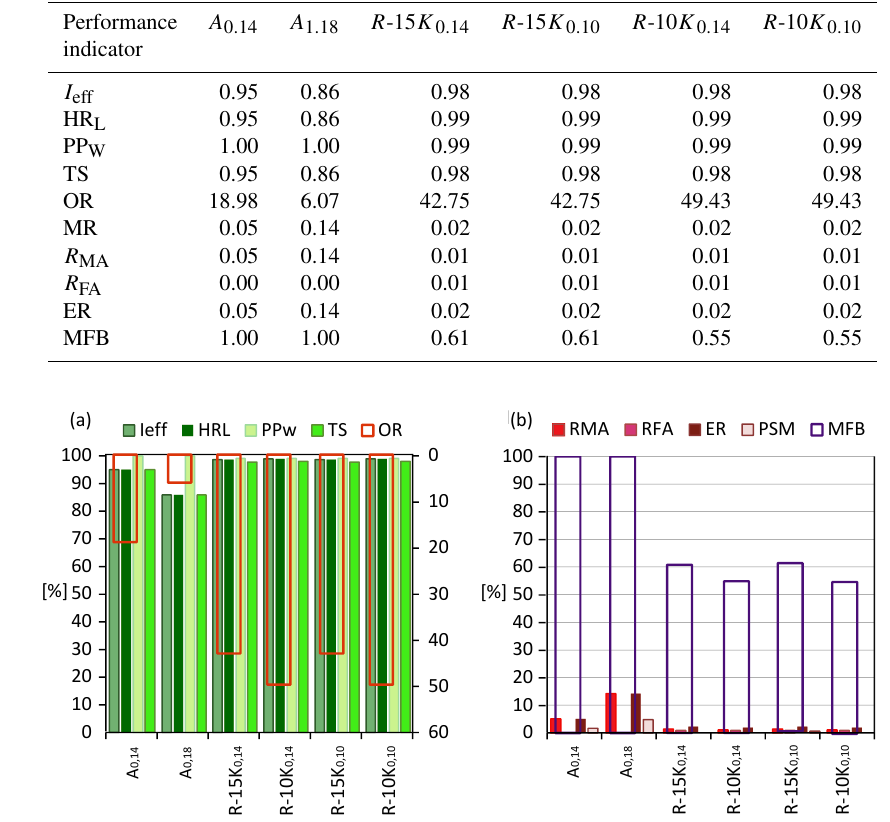
Figure 9. Performance indicators related to the success (a) and to the errors (b) of the warning model, evaluated for the six simulations of landslide density criteria considered in the parametric